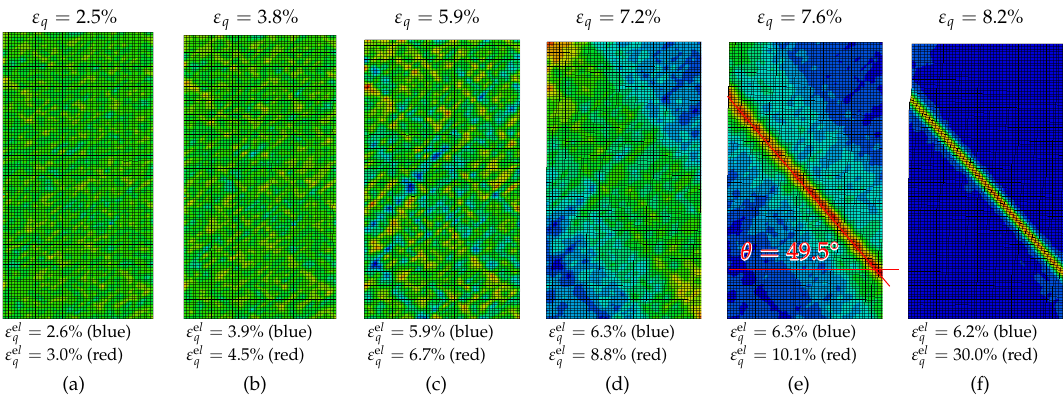
Figure 8. OCR = 6: Shear band development displayed with deviatoric strain in each element ε el q at different global deviatoric strain ε q , peak in q is at ε q = 7.0%. ( a – c ) show pre-peak pattern of shear bands, ( d – f ) post-peak pattern of shear bands.